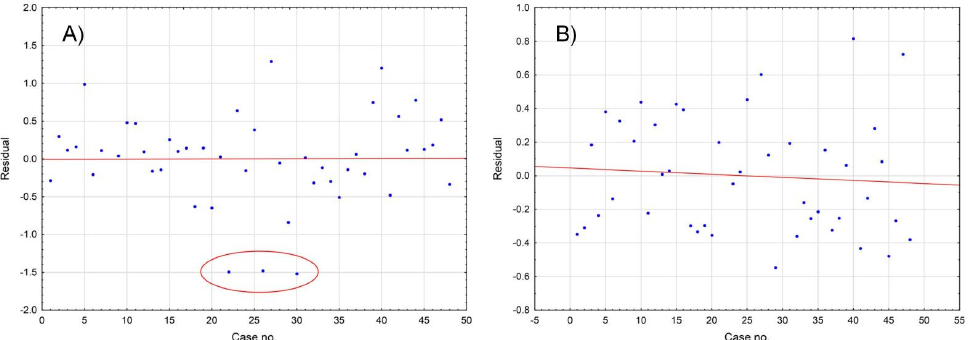
Figure A6. Distribution of residuals according to case No. corresponding to the order of runs in precipitation-sonication central composite design (Table 3): ( A ) According to initial full model built including all the plan points. The outlier residuals resulting from the inclusion of axial points at CIL concentration = 10 mg/mL are marked in red. ( B ) According to the final model built with the exclusion of axial points producing outlier residuals.